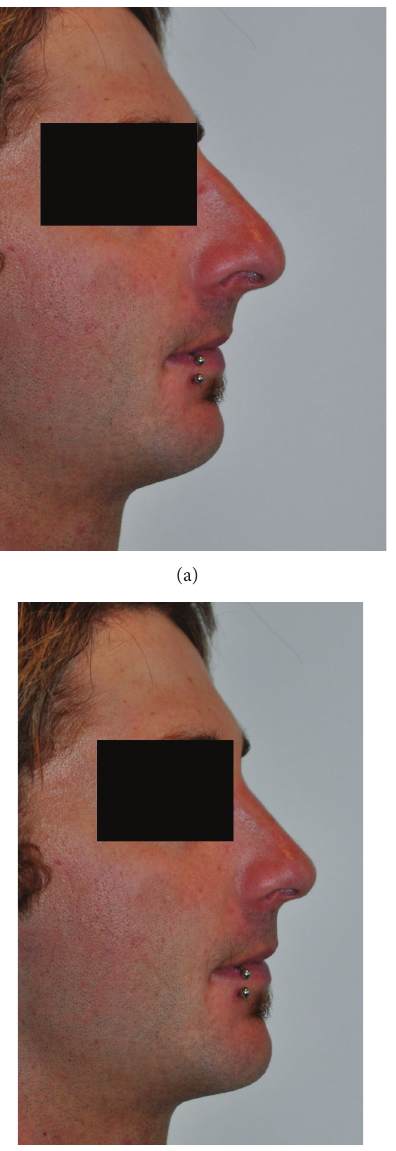
F 1: (a) Photograph of the patient preoperatively. (b) Using visualphotographicreconstructiontodemonstratefacialaugmenta- tion—planned nasal dorsal hump reduction and augment chin into alignment with mid facial plane.